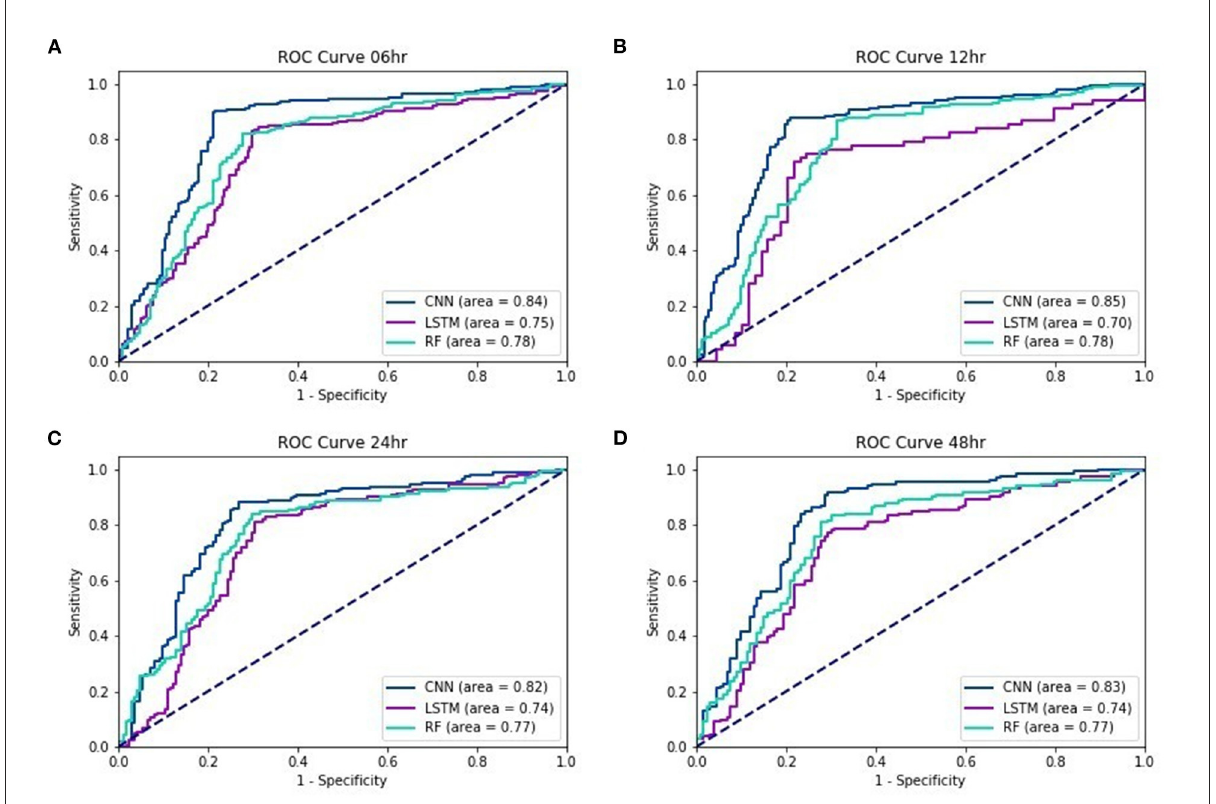
FIGURE2 ROC curves of EWS_C, EWS_L, and EWS_R: (A) 6 (B) 12, (C) 24, and (D) 48h lead